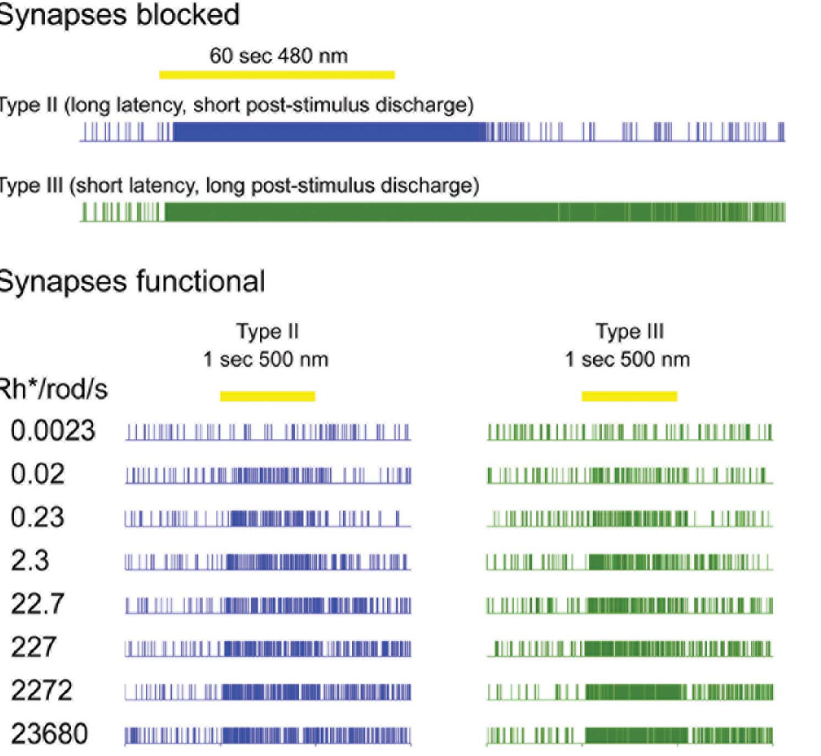
Figure 8. ipRGCs with distinct types of intrinsic light response exhibit similar synaptically driven photoresponses. Upper panel: raster plots of two representative ipRGCs with distinct kinetics of melanopsin-driven intrinsic photoresponse, apparently corresponding to two types defined by Tu et al., (2005) in adult mice. Type II cell (blue) has long onset latency and shorter post-stimulus discharge; Type III has short latency and prolonged afterdischarge. Stimulus was a 60 sec light step (yellow bar; 480 nm, , 6 6 10 12 photons/cm 2 ? s). Recordings were performed under synaptic blockade. Lower panel: intensity-response series of the same two cells, but without synaptic blockade. The light stimuli were one second flashes 500 nm flashes ascending in intensity within the series. Both cells showed the same irradiance-response properties, with thresholds approximately 0.02 Rh*/rod/s.